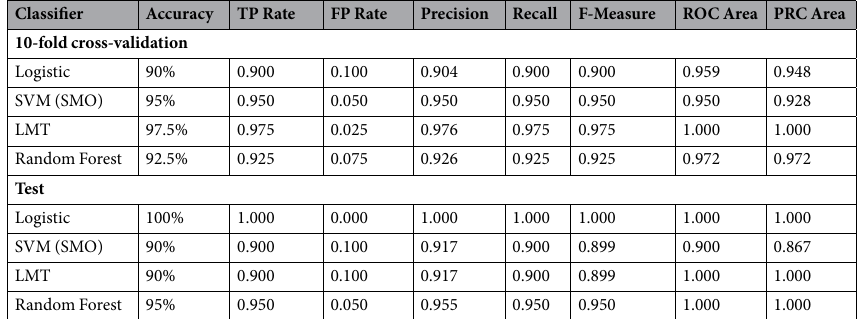
Table 5. The table reports the percentage of accuracy obtained on the training set using a 10-fold cross- validation procedure and in the test set (20 new participants) for four different machine learning classifiers. In addition to accuracies, the table reports the weight average of True Positive Rate (TP Rate), False Positive Rate (FP Rate), Precision value, Recall value, F-Measure, Receiver Operating Characteristics (ROC) Area value and Precision-Recall Curve (PRC) Area